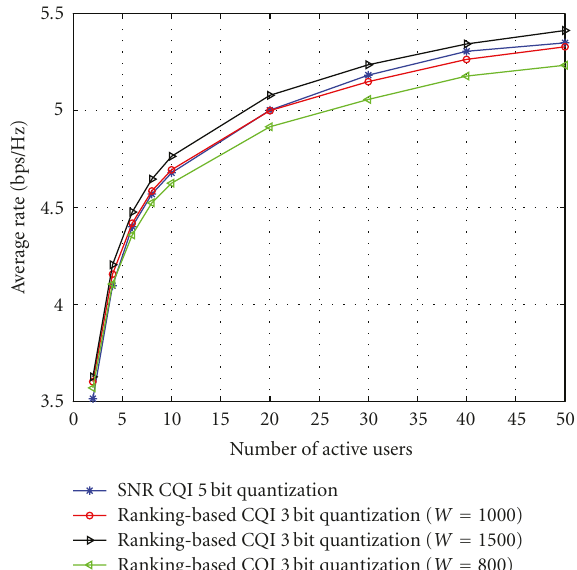
Figure 4: Average rate as a function of the number of users for single-beam RBF with M = 2 antennas, for SNR = 10 dB and di ff erent values of window size W. With proper choice of W , ranking-based user selection can reduce the feedback load as compared to signal-to-noise ratio (SNR)-based RBF with no throughput reduction.